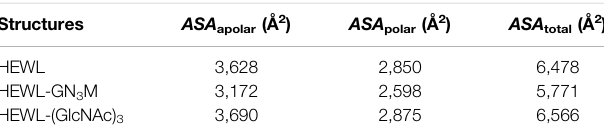
TABLE 2 | The solvent accessible surface areas ( ASAs ) of ligand-bound and ligand-free HEWL.